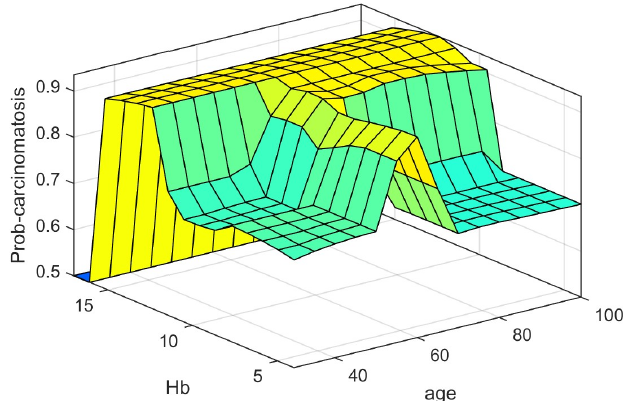
Figure 12. Prob-carcinom variation with Hb and Age.